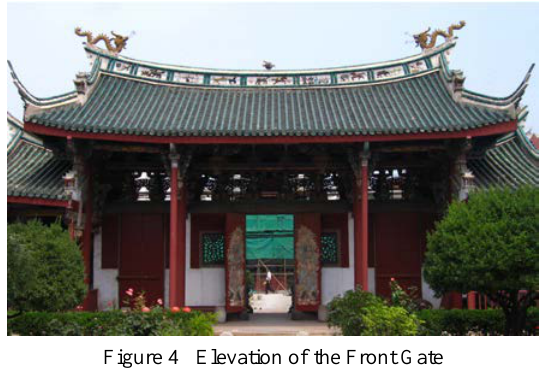
Figure 4 Elevation of the Front Gate